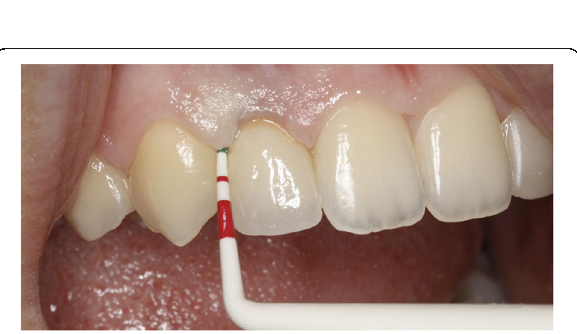
Fig. 2 Probing of the peri-implant